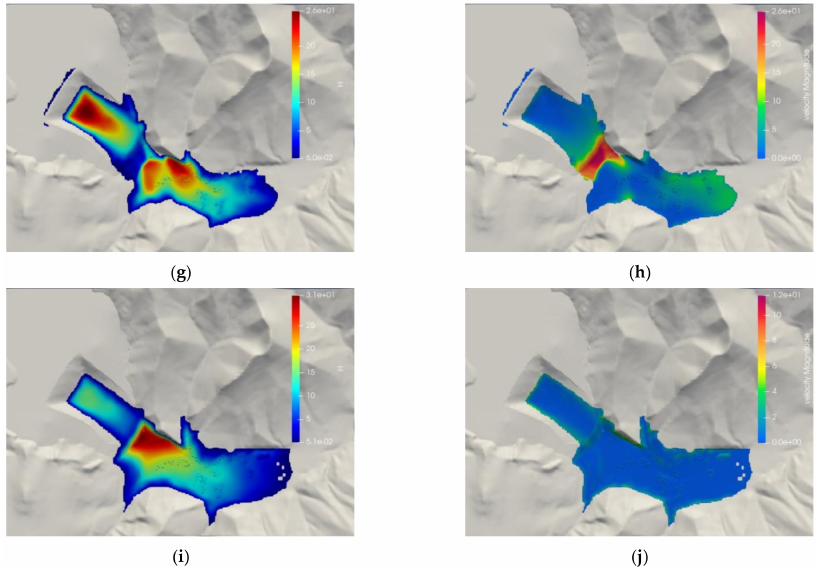
Figure 10. The process of tailing sand discharge from the breached dam. ( a ) Height distribution of tailing sand accumulation at 20 s. ( b ) Tail sand flow rate distribution at 20 s. ( c ) Height distribution of tailing sand accumulation at 40 s. ( d ) Tail sand flow rate distribution at 40 s. ( e ) Height distribution of tailing sand accumulation at 60 s. ( f ) Tail sand flow rate distribution at 60 s. ( g ) Height distribution of tailing sand accumulation at 80 s. ( h ) Tail sand flow rate distribution at 80 s. ( i ) Height distribution of tailing sand accumulation at 300 s. ( j ) Tail sand flow velocity distribution at 300